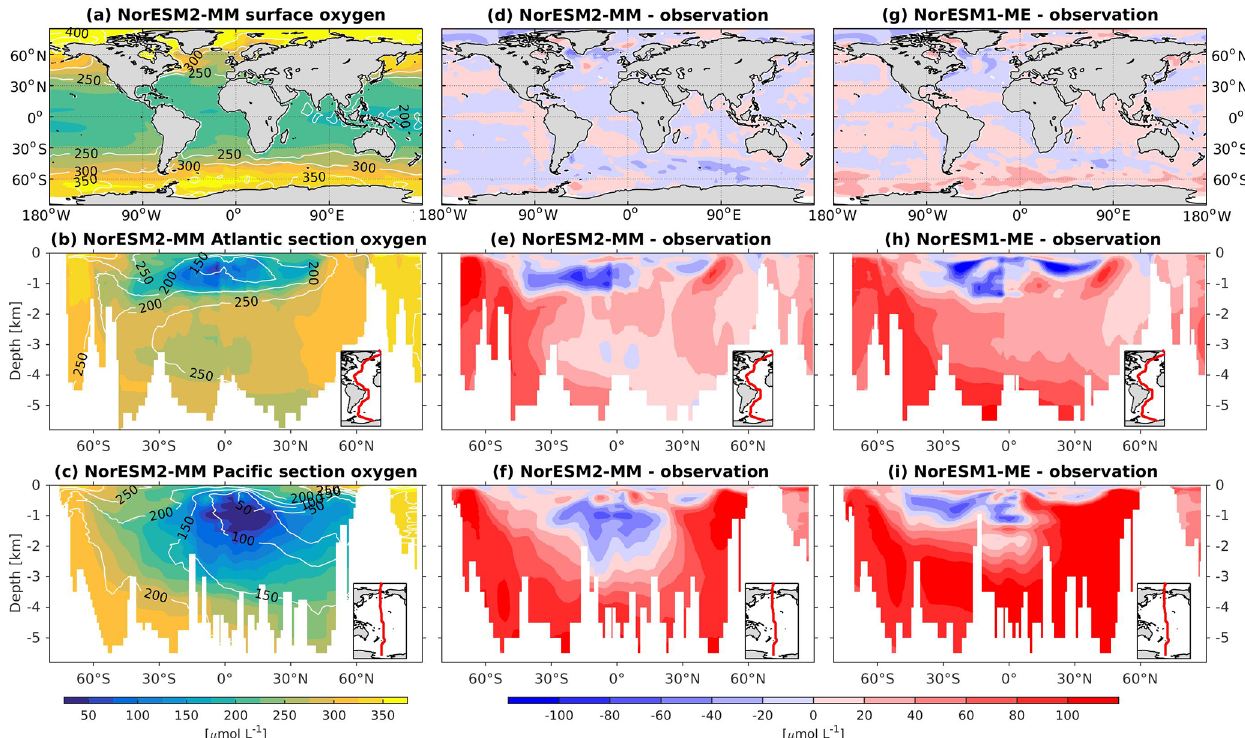
Figure 11. Climatological dissolved oxygen values at the (a) surface and across the vertical sections of (b) the Atlantic and (c) Pacific in NorESM2-MM (colour shadings) and from observations (contour lines). Differences between NorESM2-MM (or NorESM1-ME) and observations are shown in panels (d) – (i) .